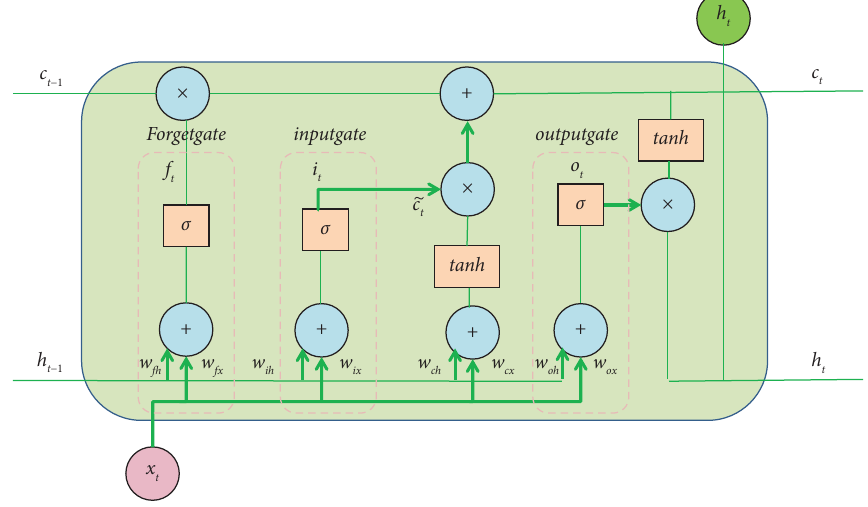
Figure 3: LSTM cell